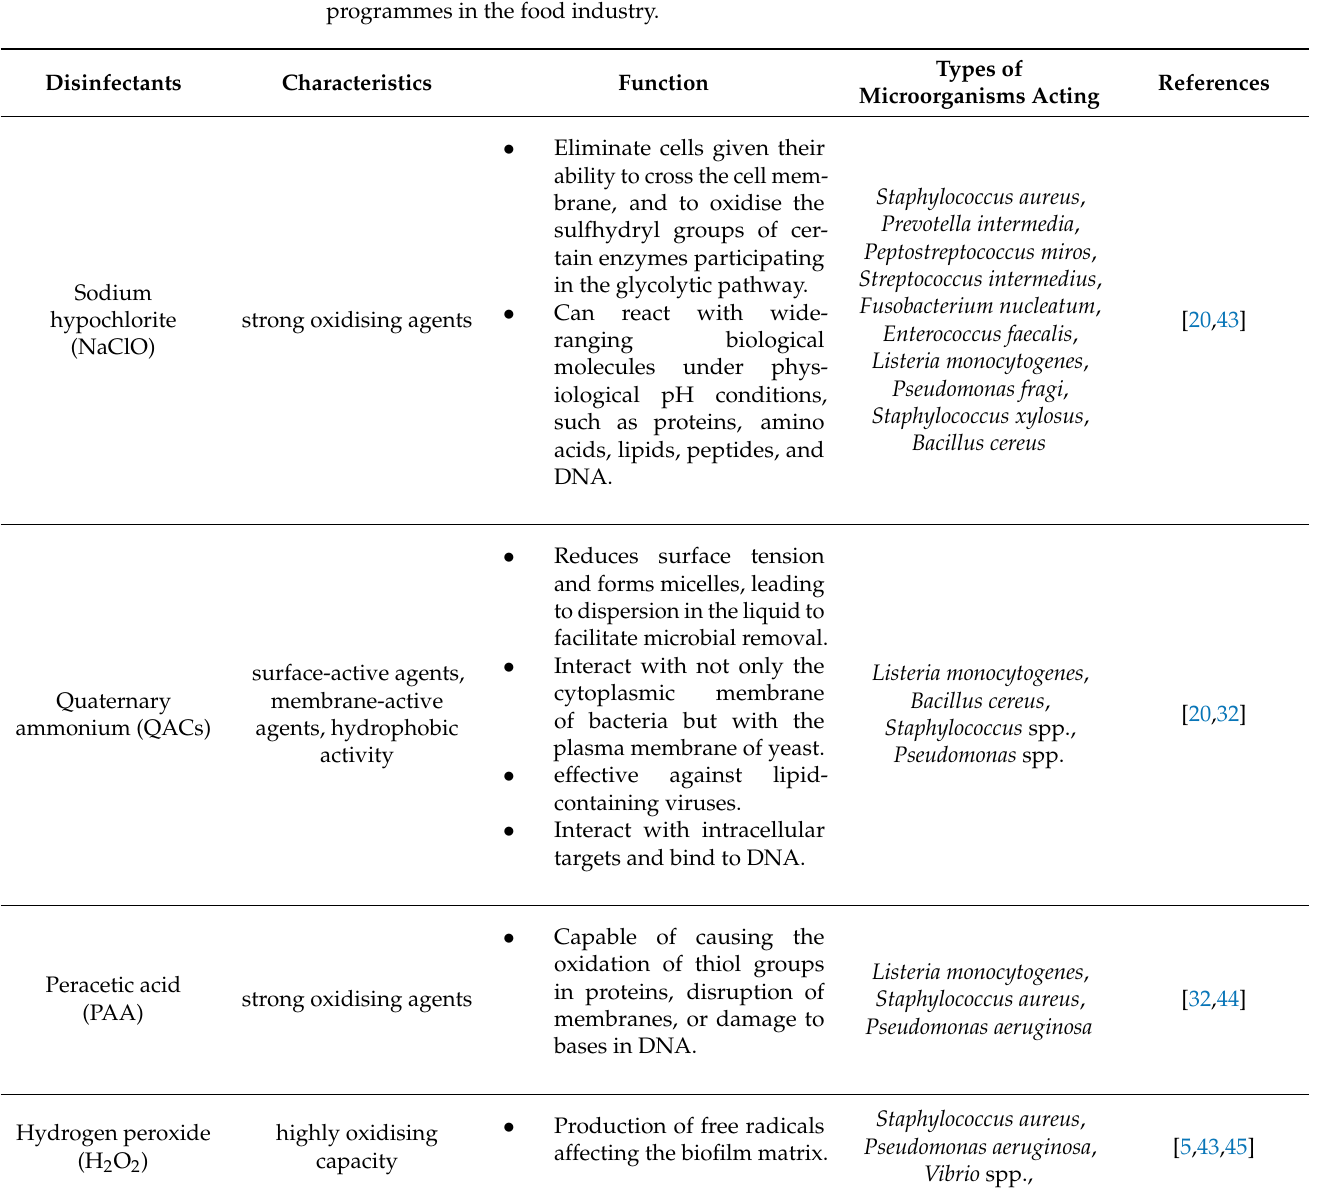
Table 1. Representative compounds for the most common disinfectants used in sanitary disinfection programmes in the food